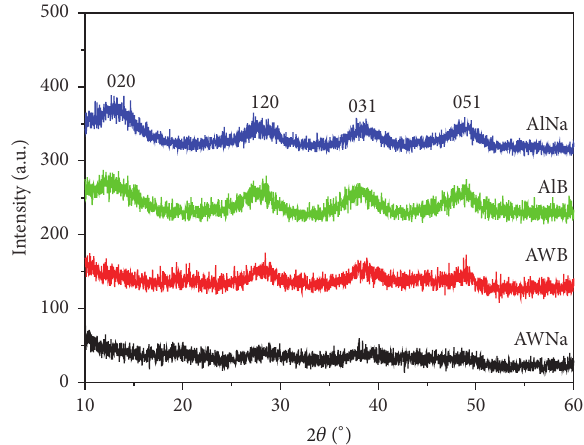
Figure 3: XRD patterns of boehmite obtained from AlCl 3 ⋅ 6H 2 O (AlNa, with NaOH, and AlB, with n-butylamine) and aluminum waste (AWNa, with NaOH, and AWB, with n-butylamine).